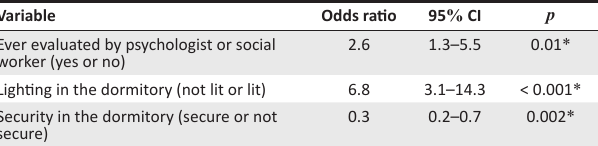
TABLE 5: Significant predictors of mass psychogenic illness amongst boarding girls (multivariate